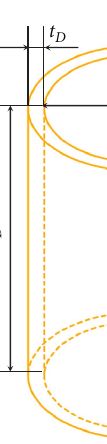
Figure 2: Schematic view of a cylindrical storage container into which segmented pieces are to be